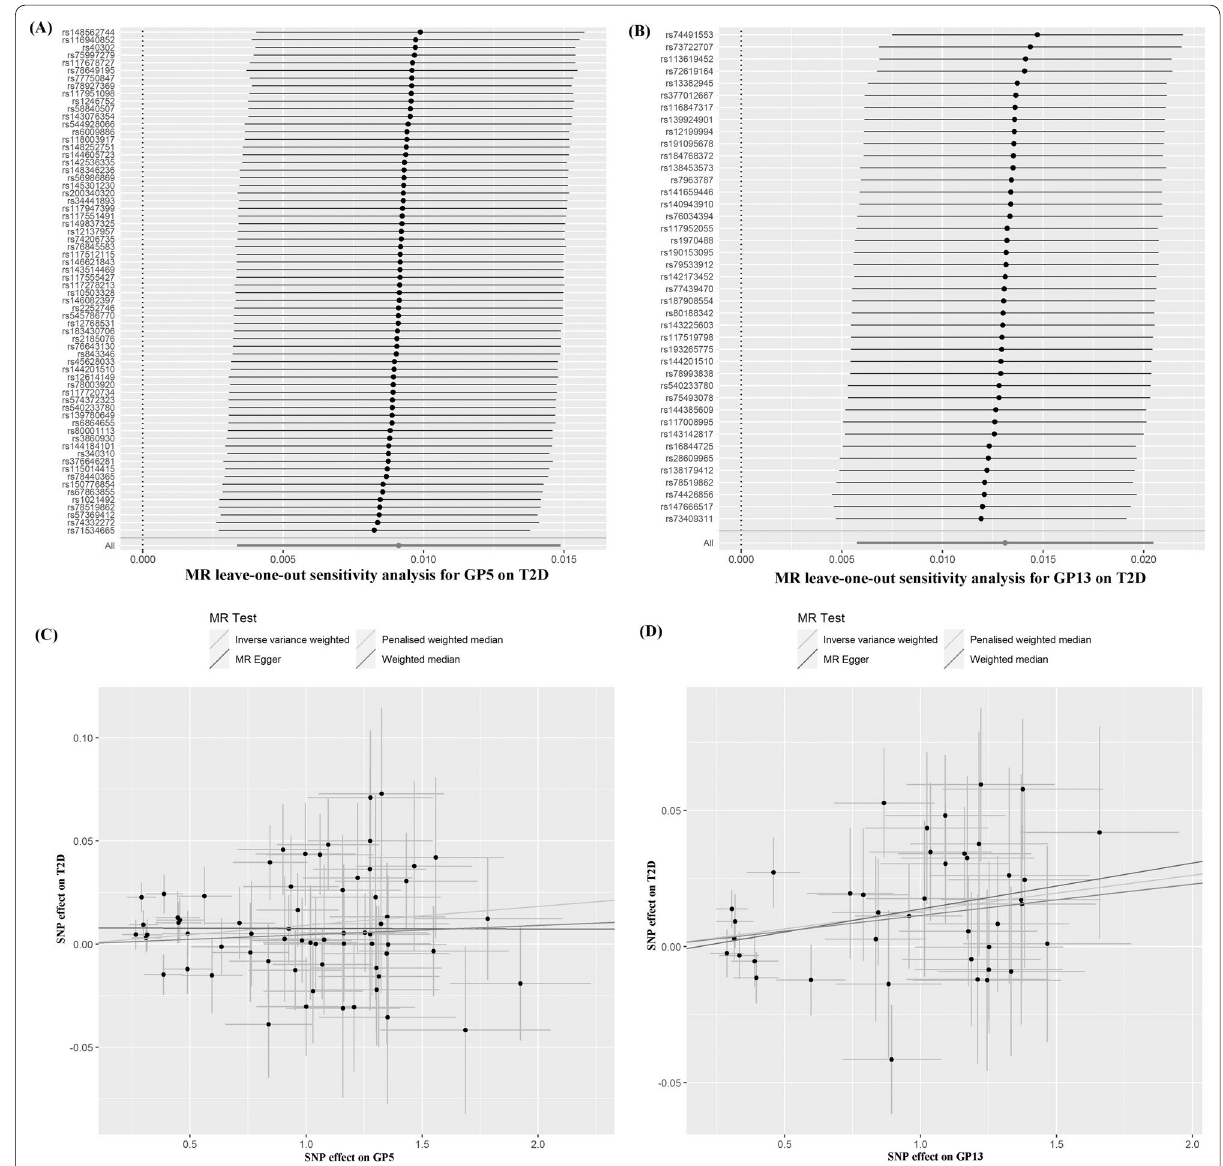
Fig. 3 Leave-one-out plots and scatter plots of IgG N-glycans on T2D in the East Asian population. A Leave-one-out plots of GP5 on T2D. B Leave-one-out plots of GP13 on T2D. C Scatter plots of GP5 on T2D. D Scatter plots of GP13 on T2D. Leave-one-out plots show the estimate of GP5/GP13 on T2D after the corresponding SNP was excluded. Scatter plots show the per-allele association with T2D plotted against the per-allele association with one standard deviation of GP5/GP13 (vertical and horizontal black lines presenting the 95% CI for each SNP), with the slope of each line corresponding to estimate the effect per method. SNP single nucleotide polymorphism, GP glycan peak, T2D type 2 diabetes, IgG immunoglobulin